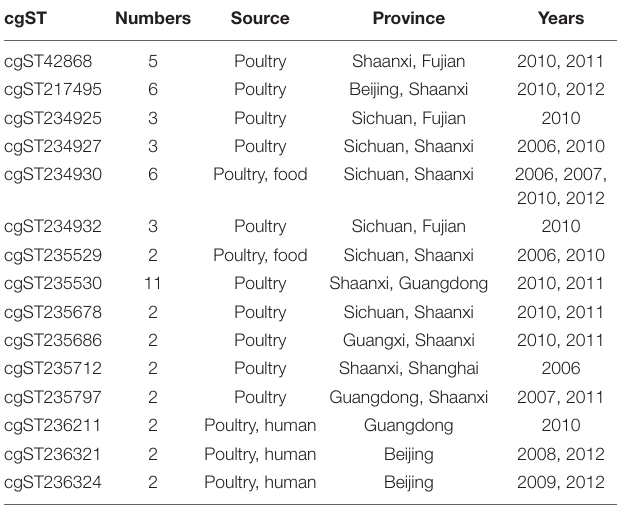
TABLE 1 | Salmonella enterica cgSTs from different years, provinces, or sources of